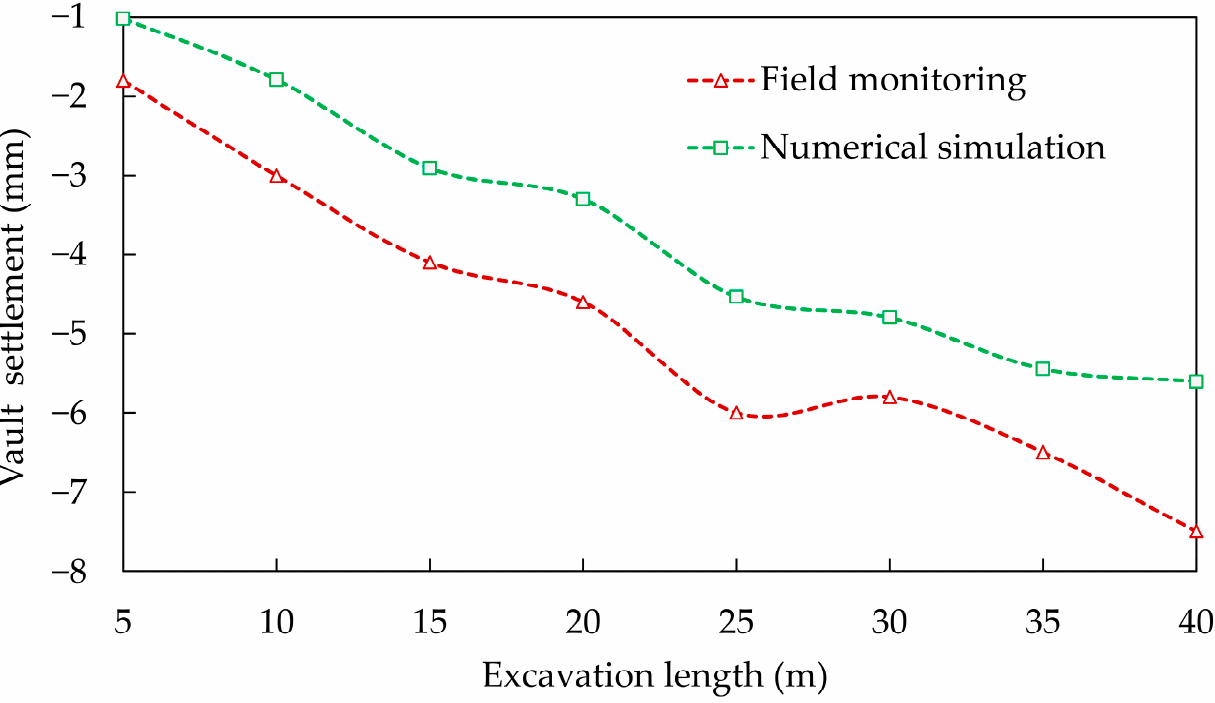
Figure 5. Comparison between the measured value and simulated value of the vault settlement.